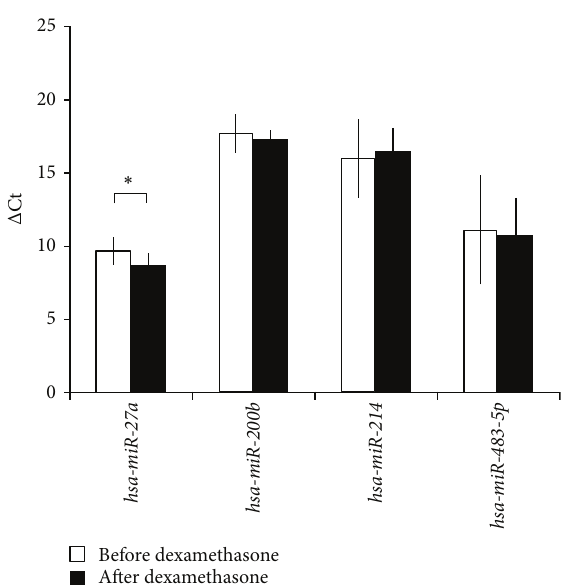
Figure 1: Expression change of microRNAs in plasma after 1 mg overnight dexamethasone test normalized to cel-mir-39 . Δ Ct values are represented: increased Δ Ct indicates lower expression, whereas decreased Δ Ct indicates higher expression (mean ± SD). ∗ 𝑝 < 0.05 , 𝑛 = 10 . 𝑡 -test was performed following the Shapiro-Wilks normality test.